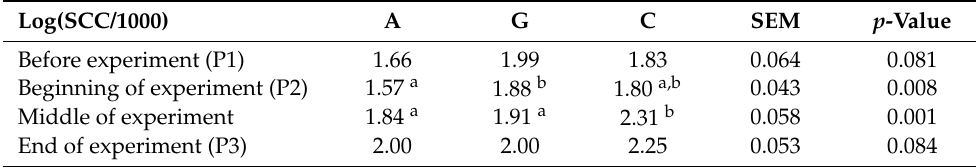
Table 2. Somatic cell